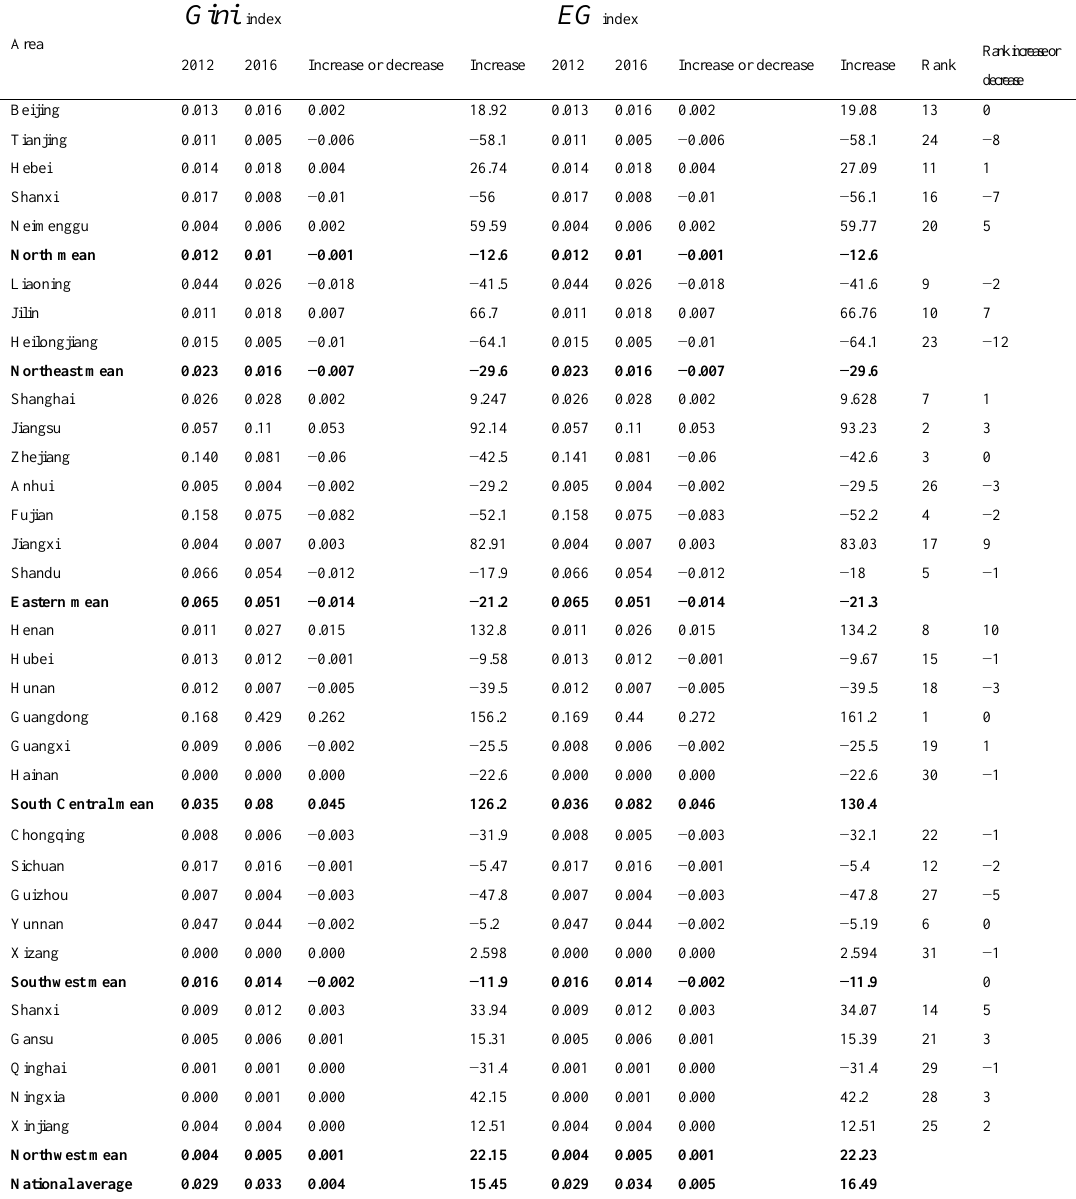
Table 1 Industrial agglomeration status of 31 provinces and cities in China’s manufacturing industry from 2012 to 2016